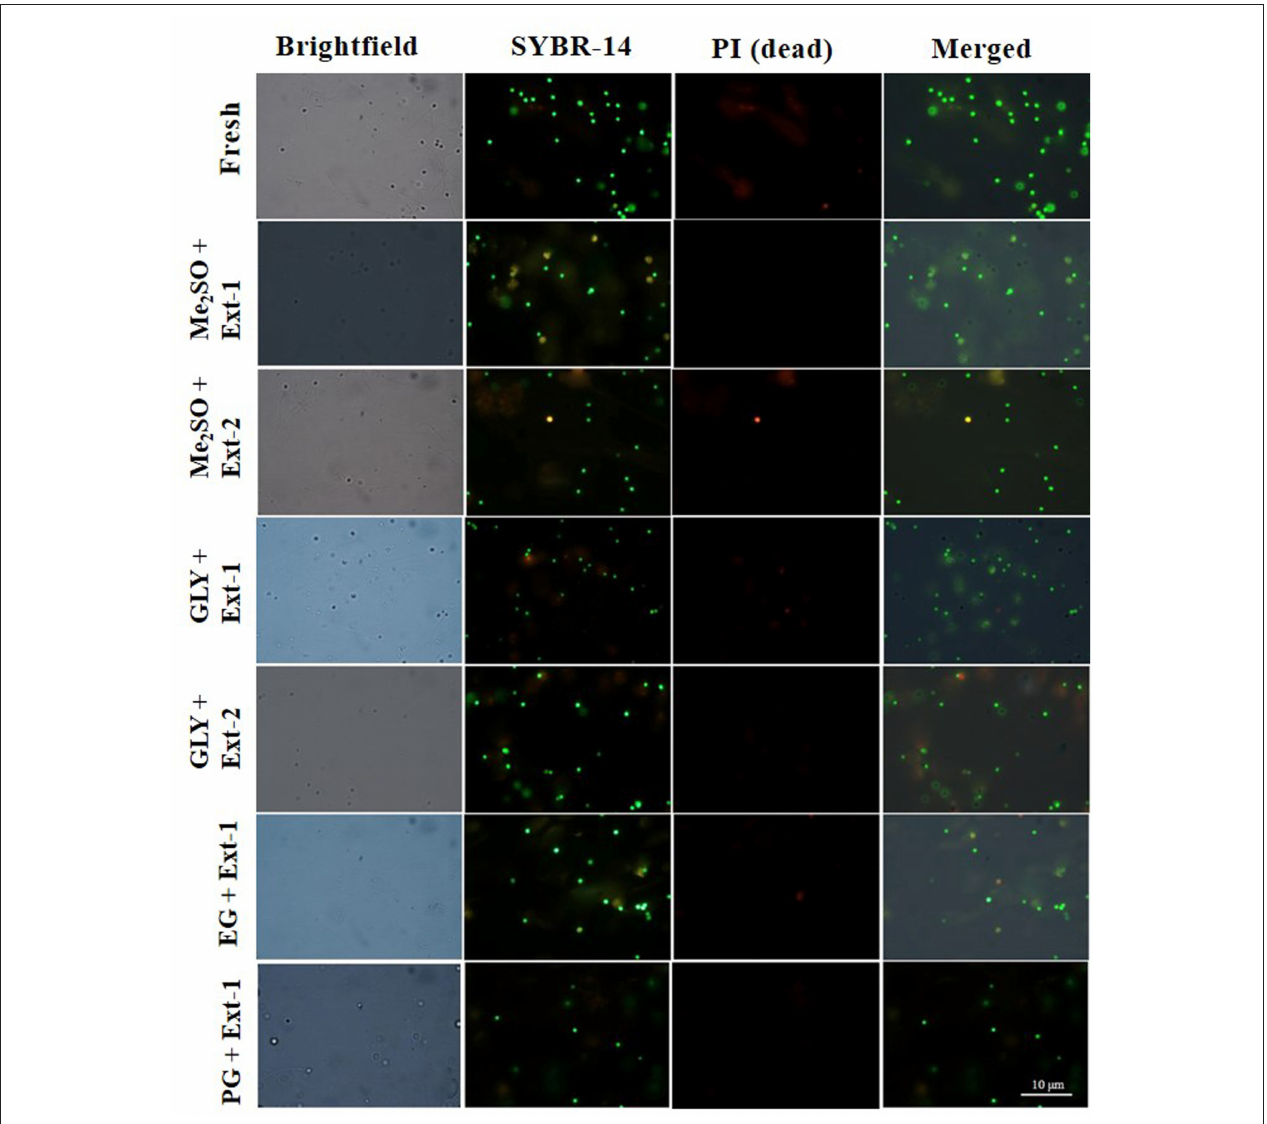
FIGURE 6 | Fluorescent-stained photographs for detecting the plasma membrane integrity of cryopreserved marbled flounder sperm ( × 100